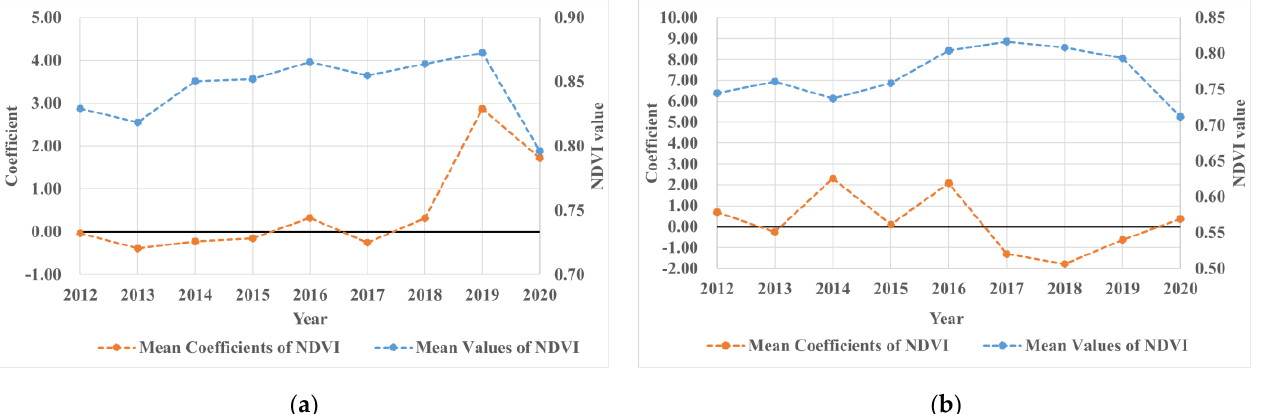
Figure 6. Temporal trends of mean NDVI values and mean NDVI coefficients in ( a ) Xuancheng and ( b ) Ma’anshan.